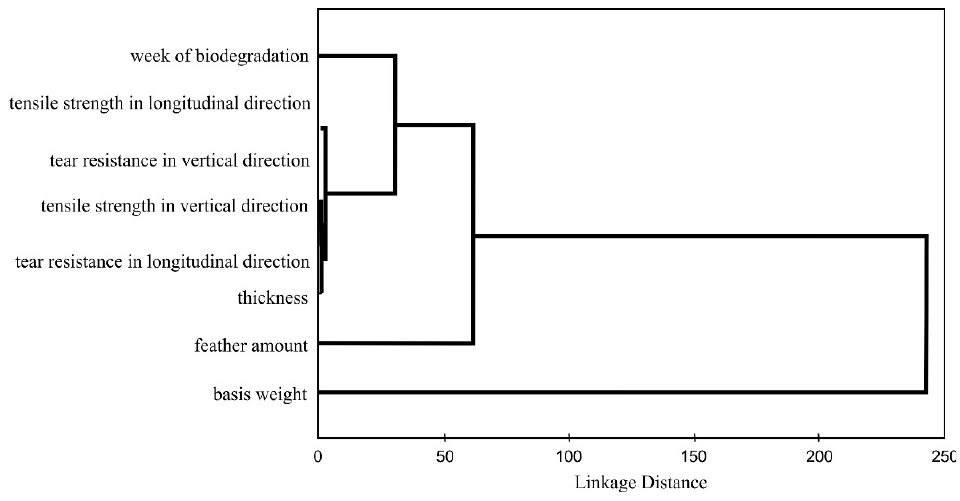
Figure 2. The biodegradation times of the samples, with and without the addition of feathers, in Group II.